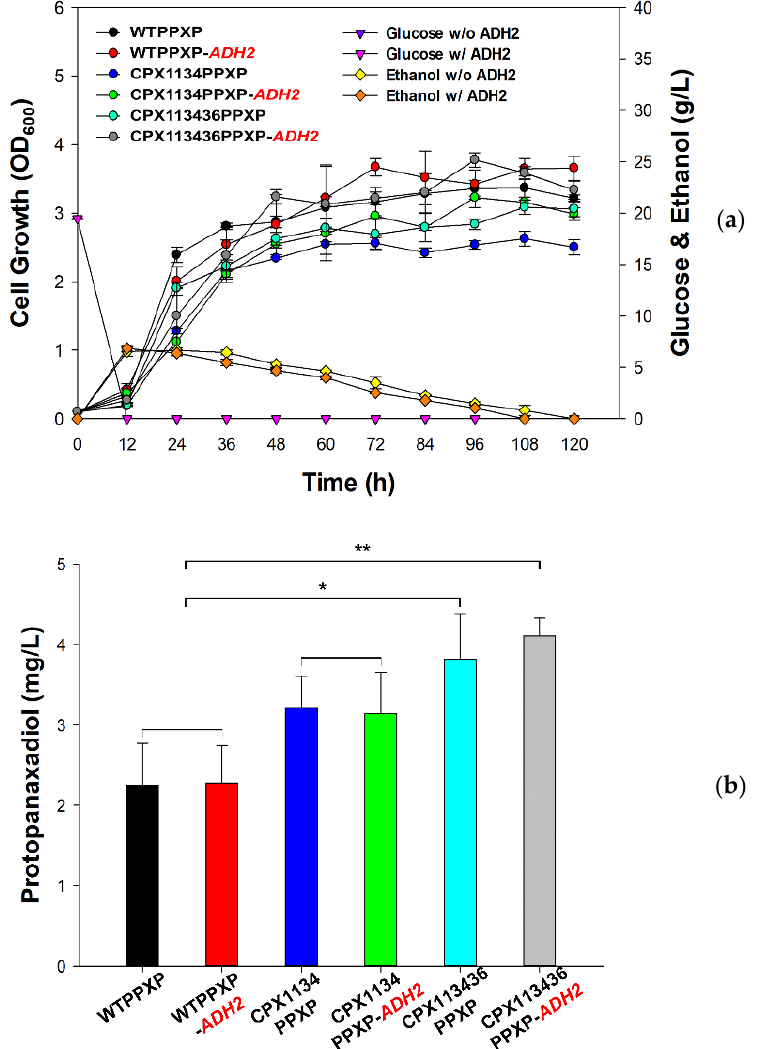
Figure 7. Cell growth and protopanaxadiol production in peroxisome-engineered and wild-type strains. ( a ) Cell growth of protopanaxadiol-producing CPX1134PPXP(pRS426), CPX1134PPXP (pRS426-ADH2), CPX113436PPXP(pRS426), CPX113436PPXP(pRS426-ADH2), WTPPXP(pRS426), and WTPPXP (pRS426-ADH2) strains cultured in synthetic defined medium containing 2% glu- cose for 120 h. ( b ) Protopanaxadiol production by CPX1134PPXP(pRS426), CPX1134PPXP(pRS426- ADH2), CPX113436PPXP(pRS426), CPX113436PPXP(pRS426-ADH2), WTPPXP(pRS426), and